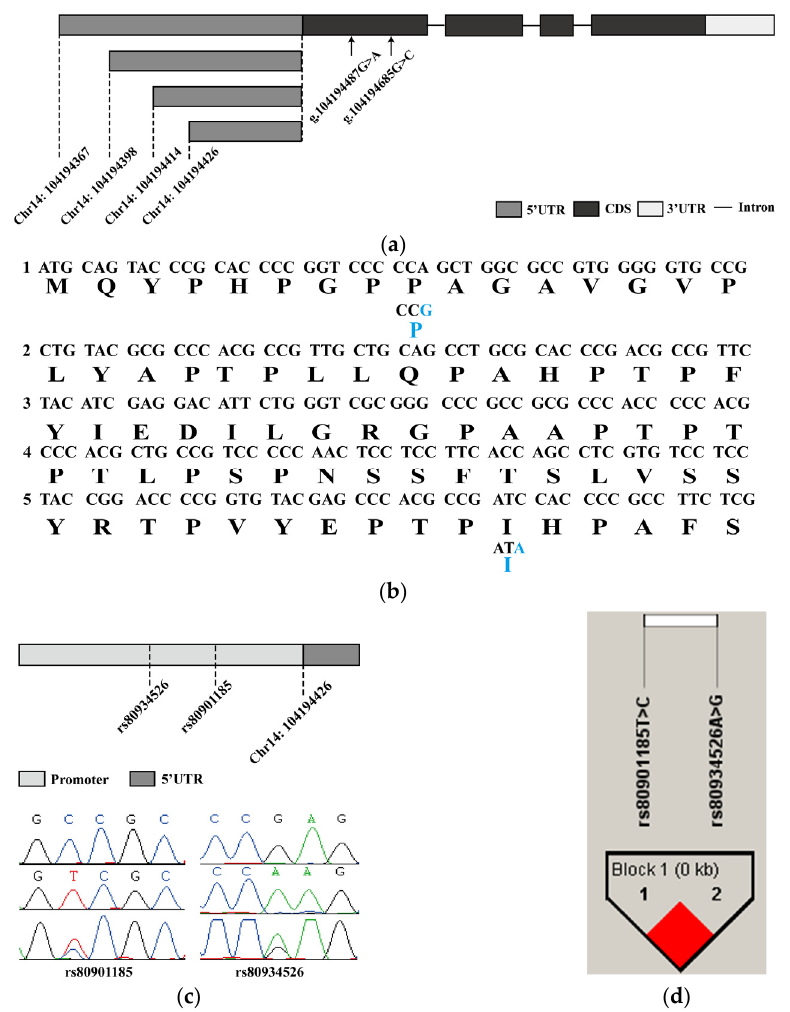
Figure 2. Polymorphism of the porcine HHEX gene. ( a ) HHEX gene structure diagram. The open reading frame is marked with a black block, the 5 ′ UTR with a gray block, the 3 ′ UTR with a white block, and the introns with line segments. The two SNPs located in the open reading frame of the first exon are marked with arrows. ( b ) Part of the open reading frame nucleotide sequence and the predicted amino acid sequence in the first exon of HHEX are shown, and the blue letters mark the SNPs (g.104194487G > A and g.104194685G > C) and the predicted amino acid changes, respectively; both were synonymous mutations. ( c ) HHEX gene promoter SNP (g.104194045T > C and g.104194173A > G) genome distribution diagram and Sanger sequencing map. ( d ) Linkage disequilibrium analysis for two polymorphisms in the porcine HHEX promoter region in Yorkshire and Wuzhishan pigs. The numbers in the boxes represent the r2 values between SNP pairs. The boxes without numbers indicate r2 = 1. The boxes are colored according to the standard Haploview color scheme: LD > 2 and D ′ = 1, red.